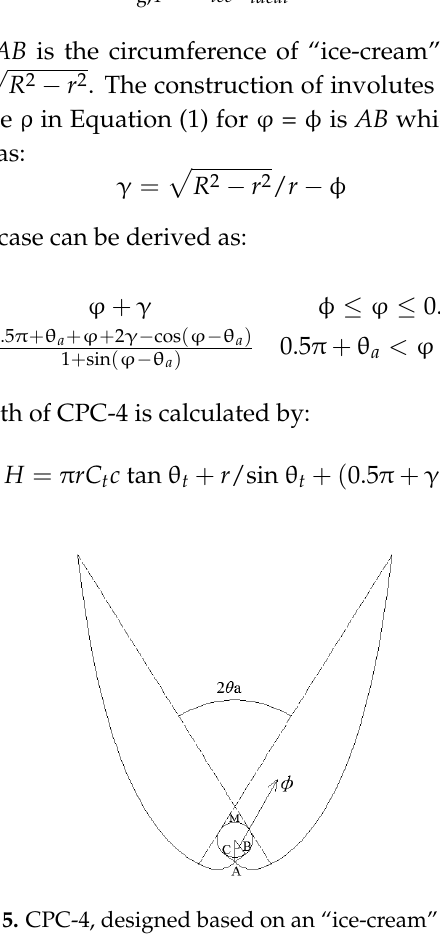
Figure 4. CPC ‐ 3, designed based on inner tube of EST with the involutes near the inner tube being truncated.